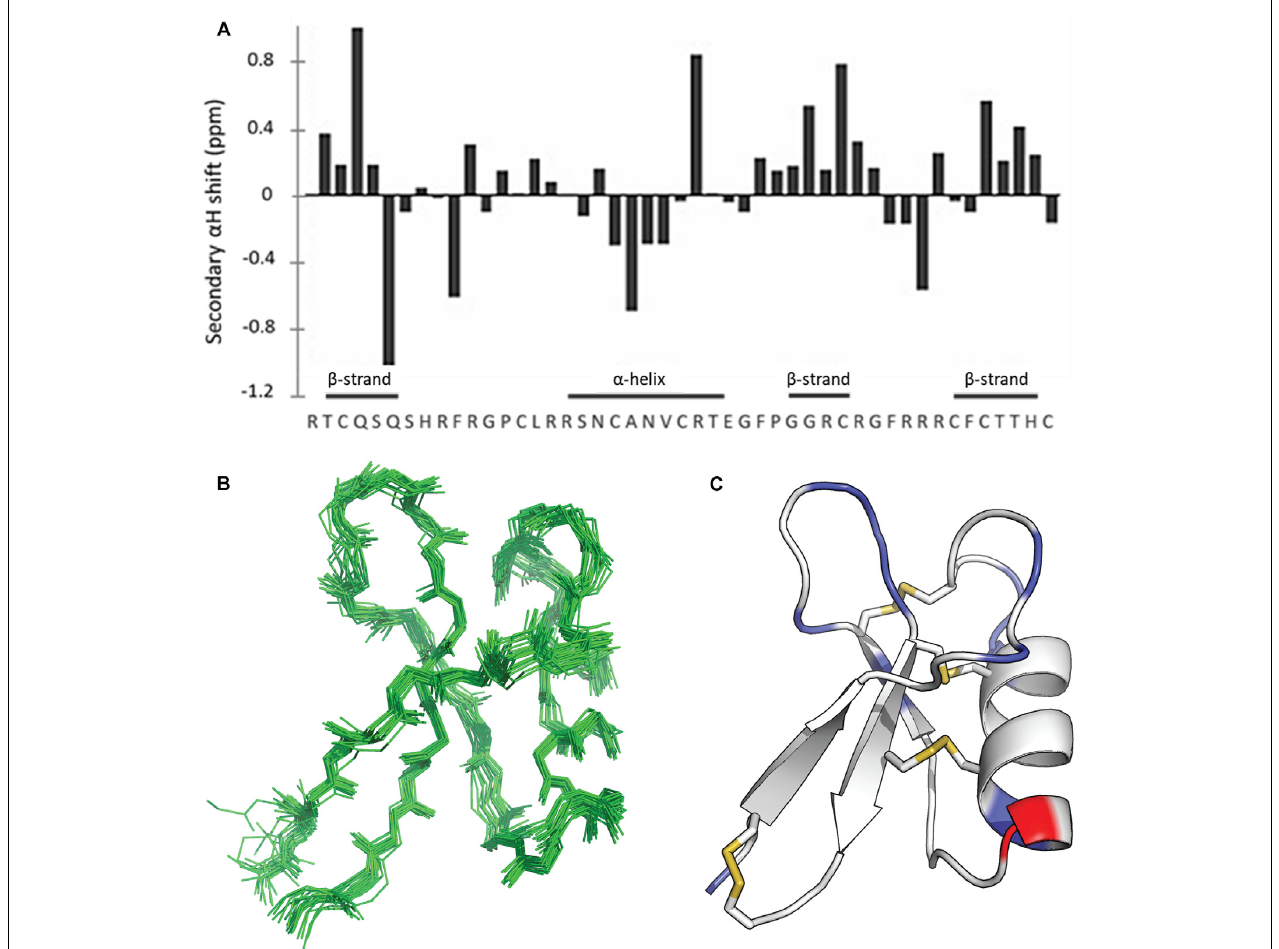
FIGURE 5 | NMR solution structure of ZmD32. (A) Secondary shift analysis of ZmD32, pH 3.5 at 298K; (B) A set of 20 lowest energy structures superimposed over all backbone atoms; (C) A ribbon representation of ZmD32 showing β -strands, α -helix, disulphide bonds (gold). The locations of positively charged residues are highlighted in blue, negatively charged residues are in